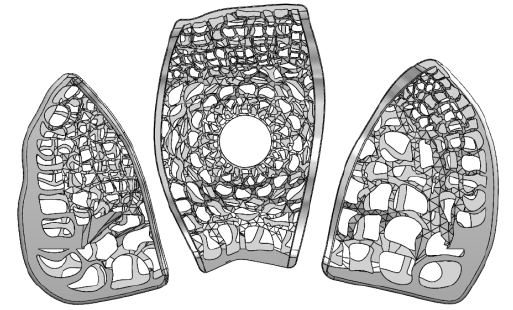
Figure 7. Cage design was separated into three parts.